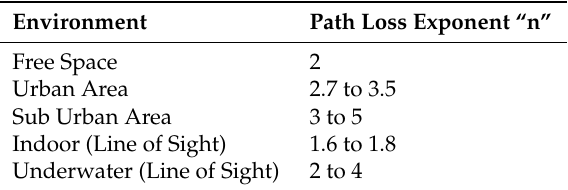
Table 2. Path loss exponent for different